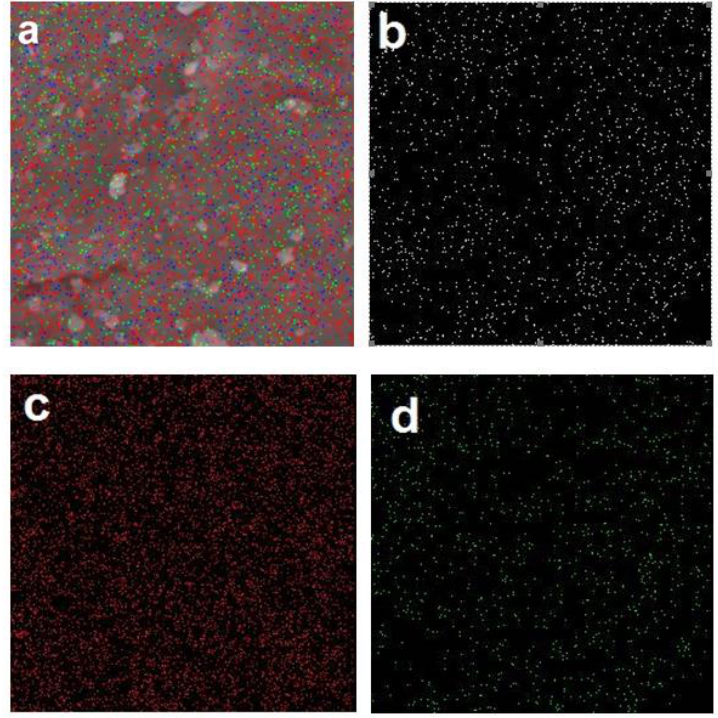
Fig. 4. EDX elemental mappings of selected area of: a) Fe, b) C, c) Cu and d) S.